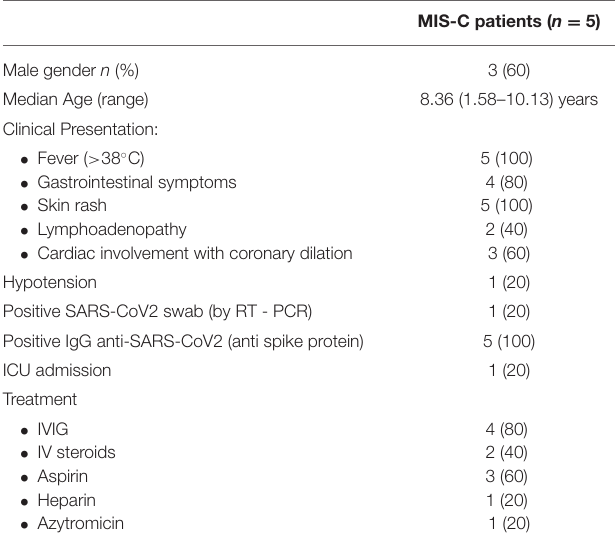
TABLE 1 | Clinical characteristics of patients with multisystem inflammatory syndrome in children (MIS-C).